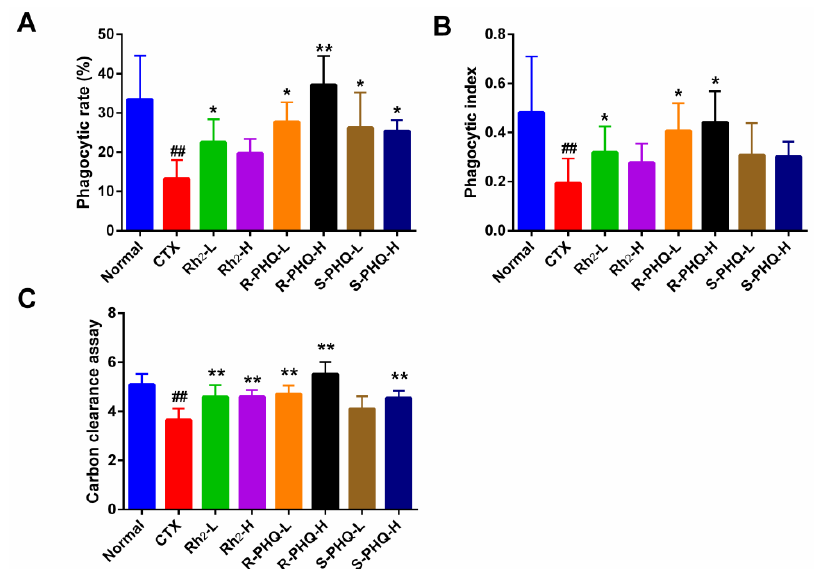
Figure 3. Effect of Rh 2 , R-PHQ, and S-PHQ on the ( A ) phagocytic rate; ( B ) phagocytic index; ( C ) carbon clearance ability. The values are presented as mean ± SD, n = 10. ## p < 0.01 compared with the normal group. ** p < 0.01 and * p < 0.05 compared with the CTX group.